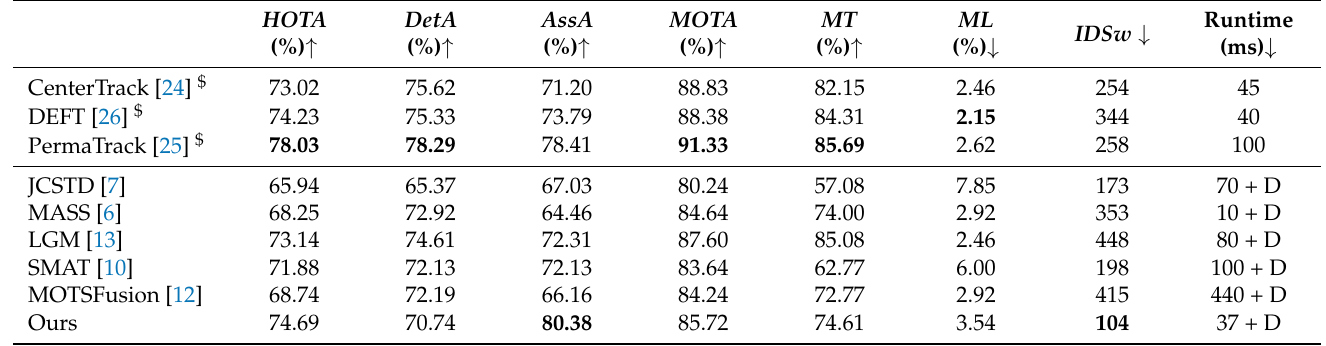
Table 3. The comparison of our method with the state-of-the-art methods on the KITTI MOT testing set.